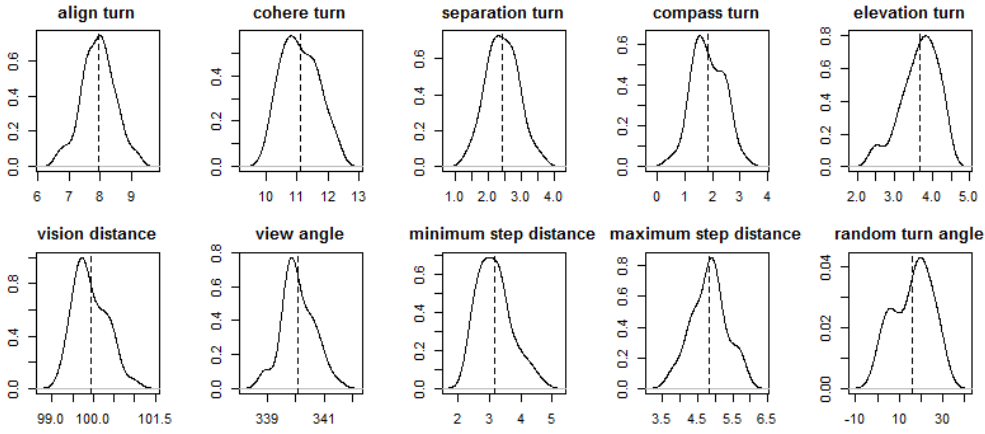
Figure 3. Density distribution of optimal model parameters.